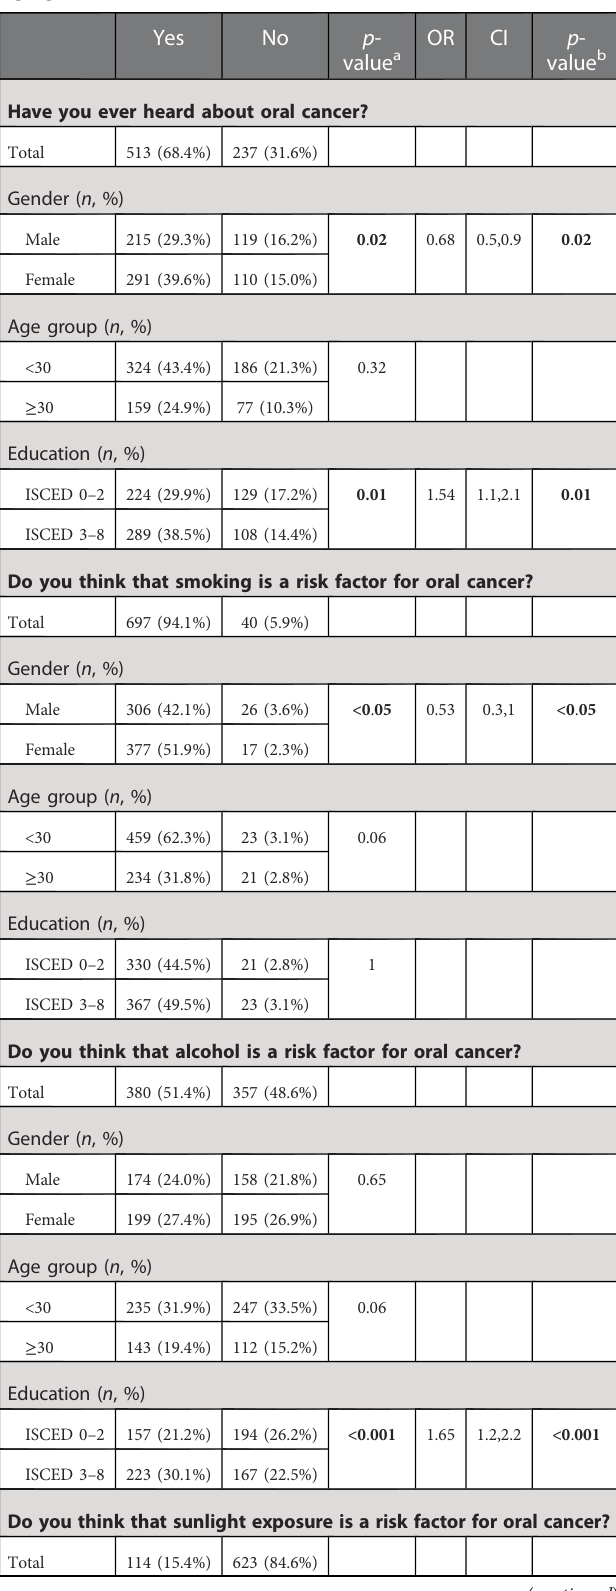
TABLE 3 Correlation of gender, age and education with knowledge about OSCC and its risk factors. Data are reported as frequency rates. A p-value <0.05 was used to reject the null hypothesis. Signi fi cant results are highlighted in